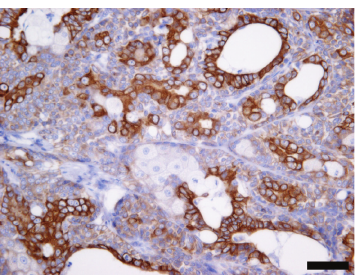
Figure 6: Both luminal and basaloid tumor cells are positive for CK8. Immunohistochemistry for CK8 with hematoxylin counter- stain. Bar = 50 𝜇